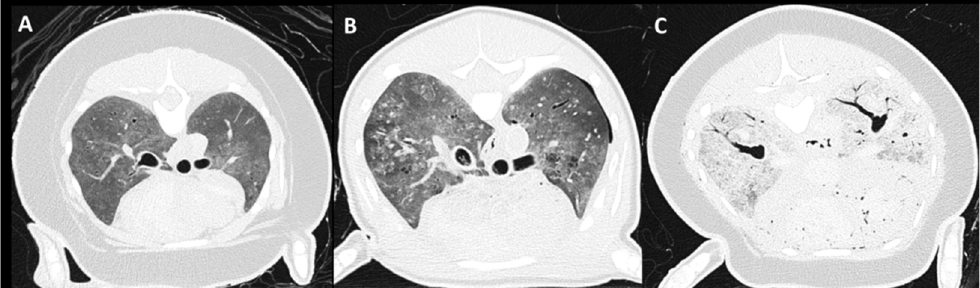
Figure 1. Examples of autolysis score on PMCT. From left to right: ( A ) mild: PSTA (pulmonary soft tissue attenuation) present in less than 25% of the lung parenchyma, ( B ) moderate: retraction of the lung margins with presence of gas in the pleural space and 25–70% of PSTA noted, and ( C ) severe: gas attenuation presence in vascular structures and other visible soft tissue structures, over 75% of PSTA present.